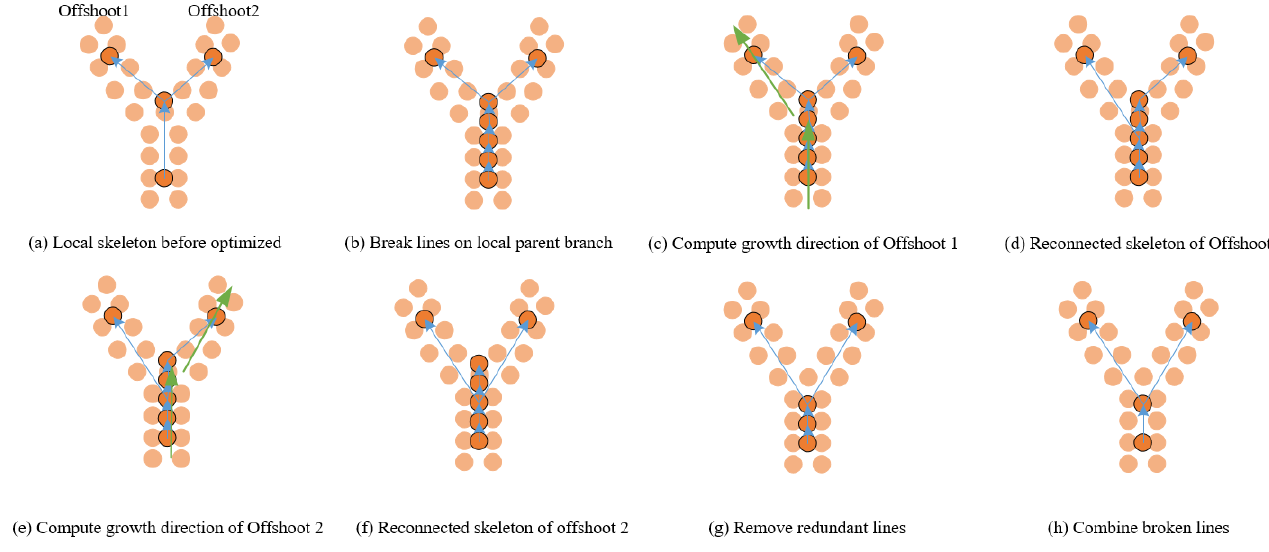
Figure 6. Bifurcation